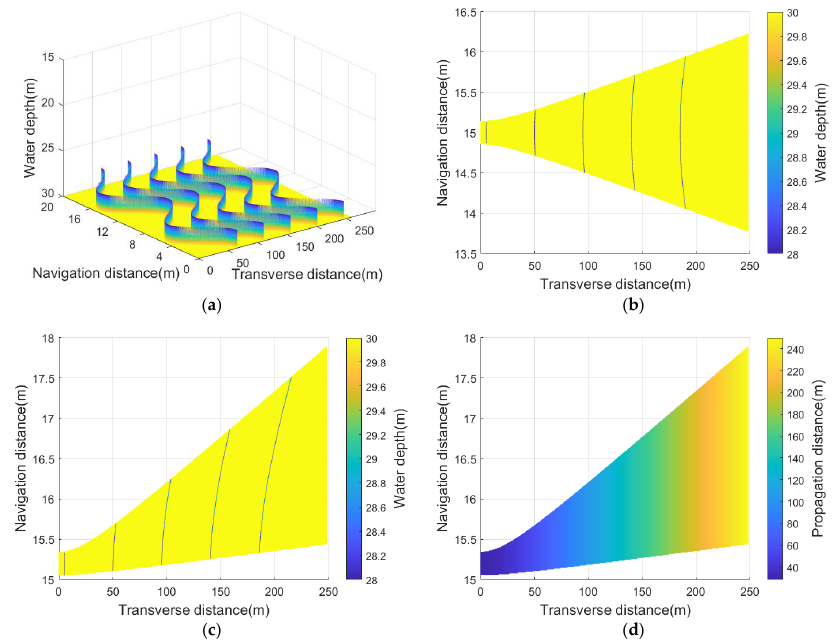
Figure 6. ( a ) A virtual seabed with 5 parallel harmonic curve targets; ( b ) the inaccurate receiving beam footprint of stop&hop path model; ( c ) the accurate receiving beam footprint of polyline path model; ( d ) acoustic propagation distance in the receiving beam footprint.